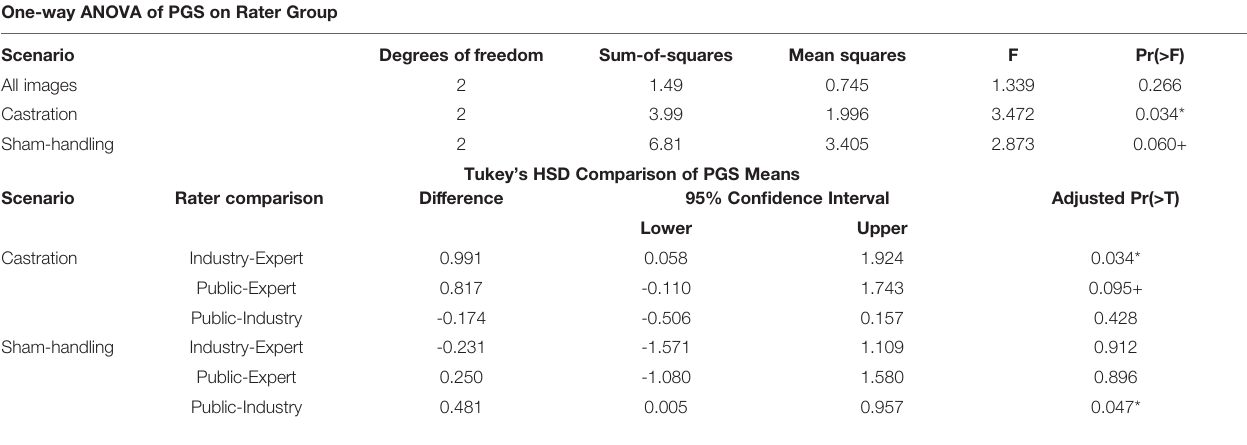
TABLE 2 | One-Way ANOVA of Piglet Grimace Scale (PGS) mean scores as a function of Rater Group by treatment with Tukey ’ s HSD post-hoc comparisons of *signi fi cant ( p < 0.05) and + marginally signi fi cant ( p < 0.10) results. One-way ANOVA of PGS on Rater Group Scenario Degrees of freedom Sum-of-squares Mean squares F Pr(>F) All images 2